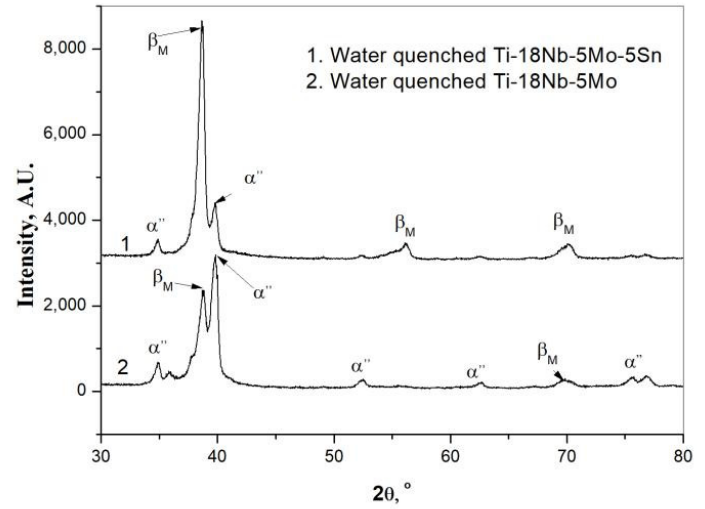
Figure 4. X-ray diffraction profiles of the water-quenched Ti-18Nb-5Mo and Ti-18Nb-5Mo-5Sn al- loys.